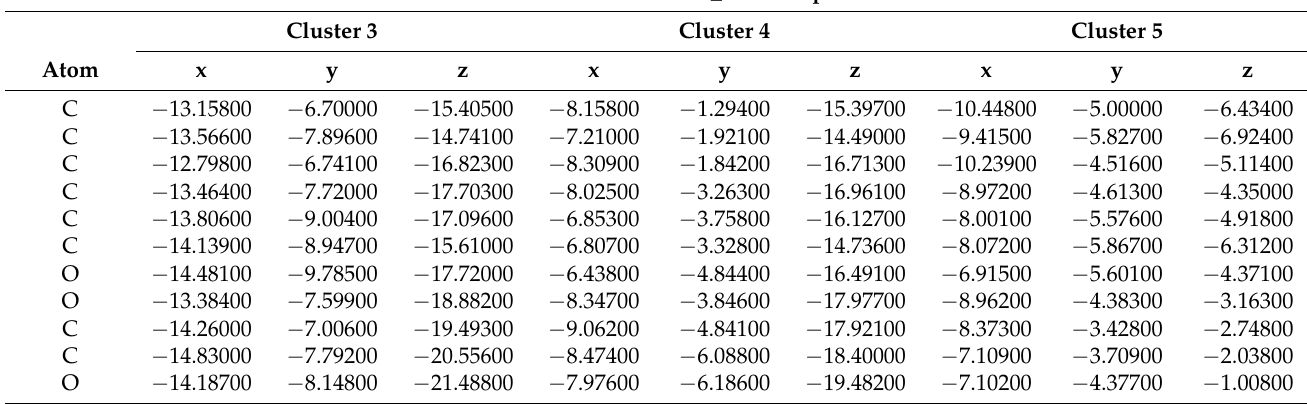
Table A2. Atomic coordinates of the system consisting of α R, β R guiacyl β − O − 4, and caffeine: cluster 3, cluster 4, and cluster 5